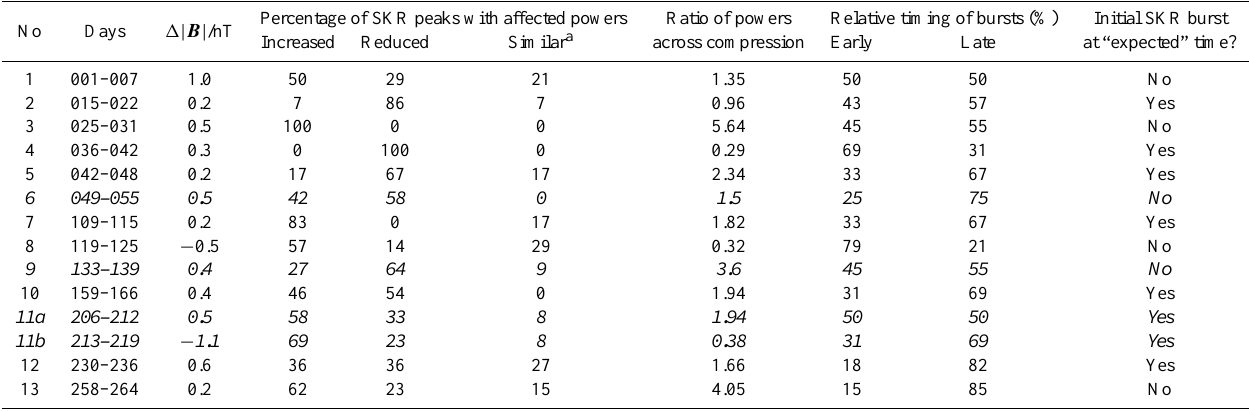
Table 1. SKR observations relating to thirteen CIR compression